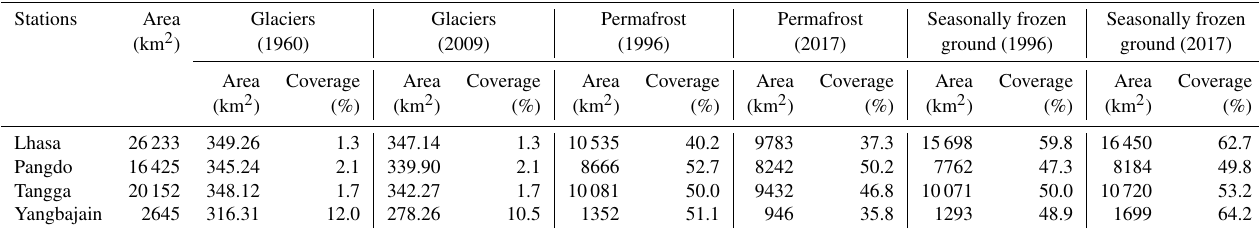
Table 3. The coverage of glaciers and frozen ground in four catchments of the Lhasa River basin.